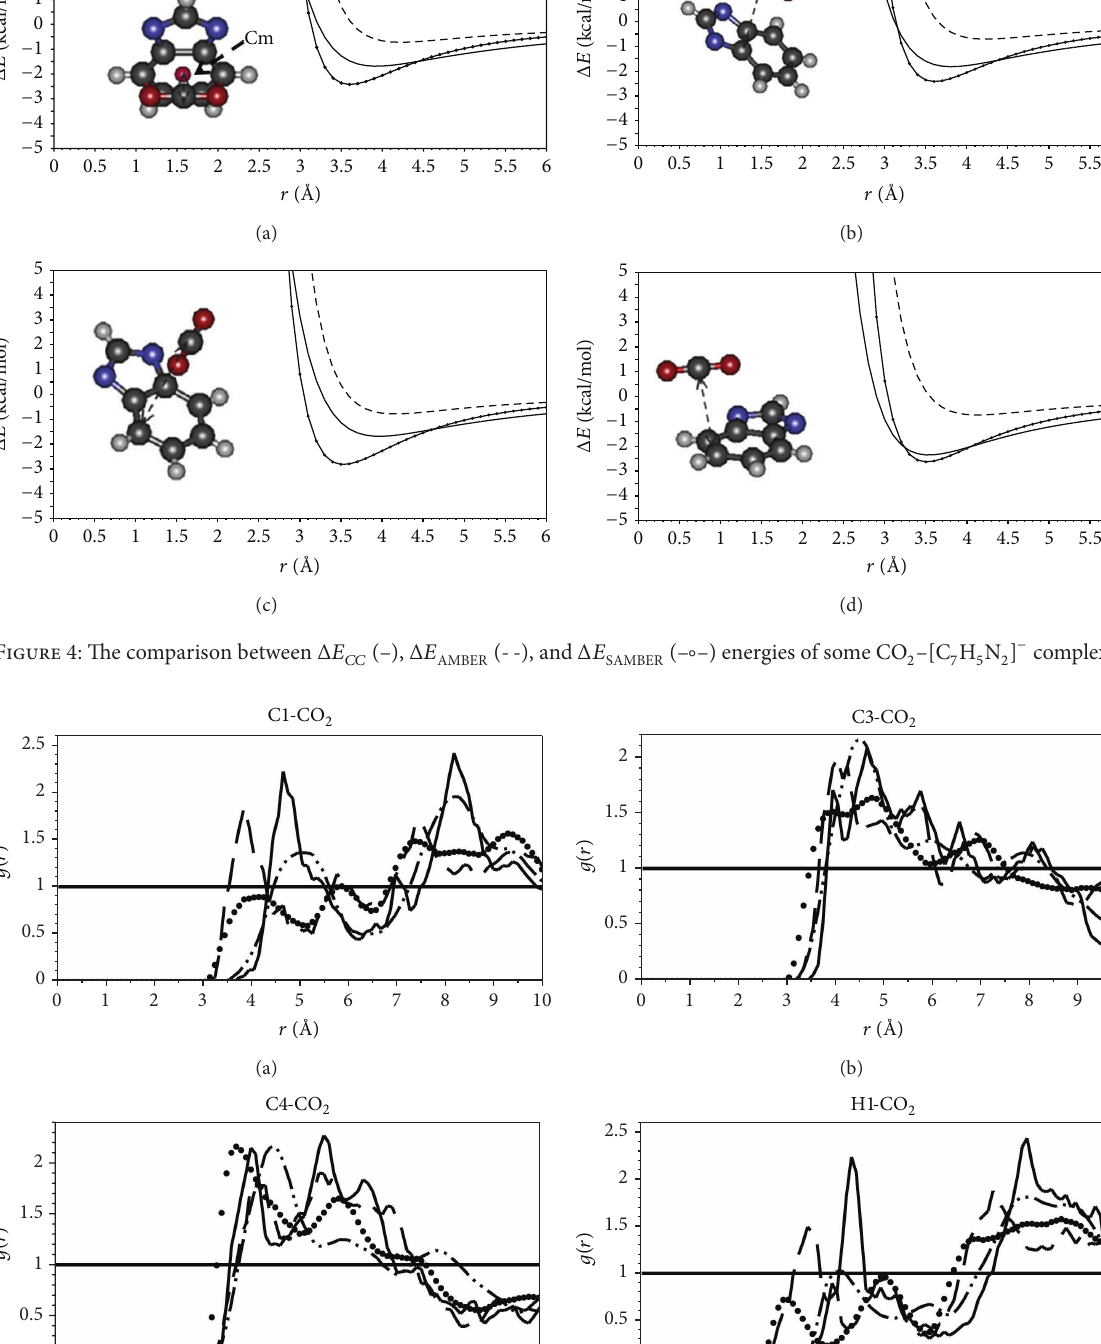
Figure 5: The obtained (a) C1-CO 2 , (b) C3-CO 2 , (c) C4-CO 2 , and (d) H1-CO 2 RDFs of SIM I (—X–C, – ∙∙ –X–O) and SIM II (––X–C, ∙ ∙ ∙∙ X–O) when X=C1, C3, C4, and H1,